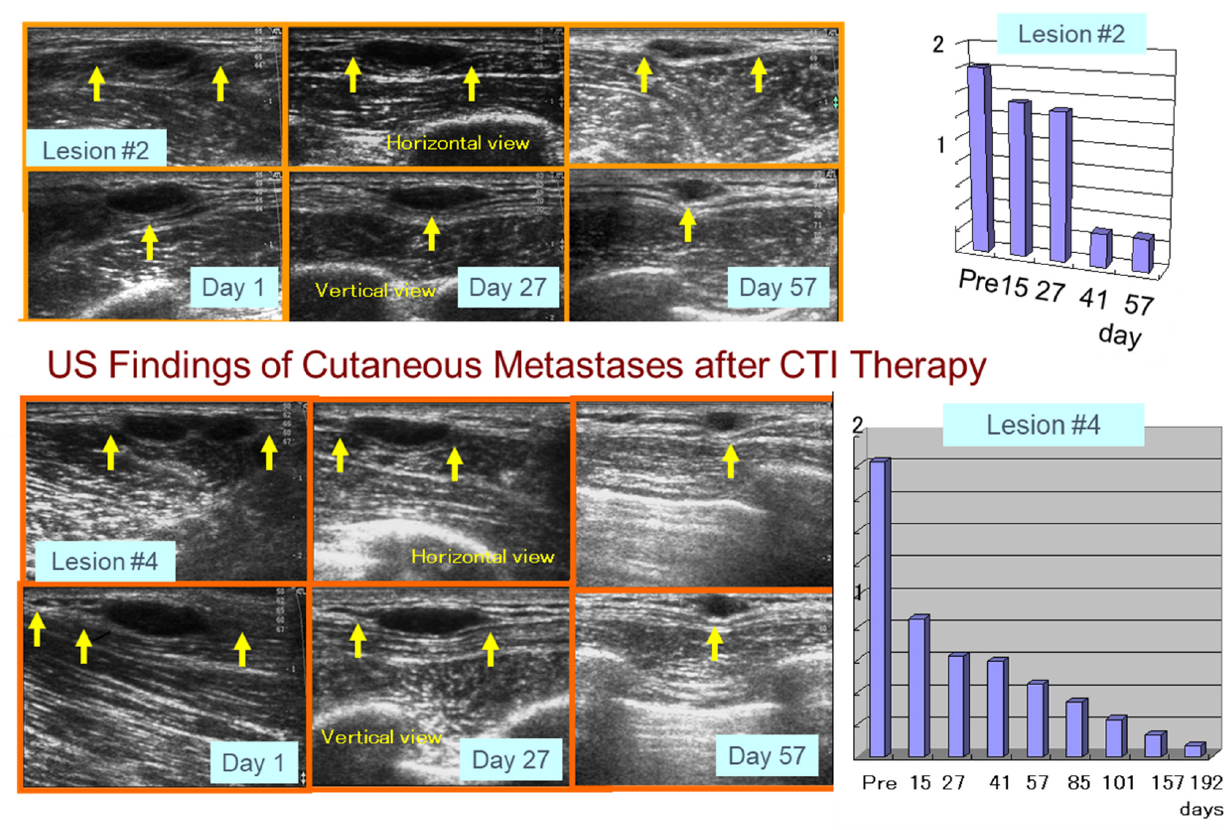
Figure 18. Ultrasound (US) findings of distant melanoma metastases after CTI therapy. Arrows in the photo indicate horizontal and vertical views of metastatic tumors comparing the decreased size of the tumor volume.